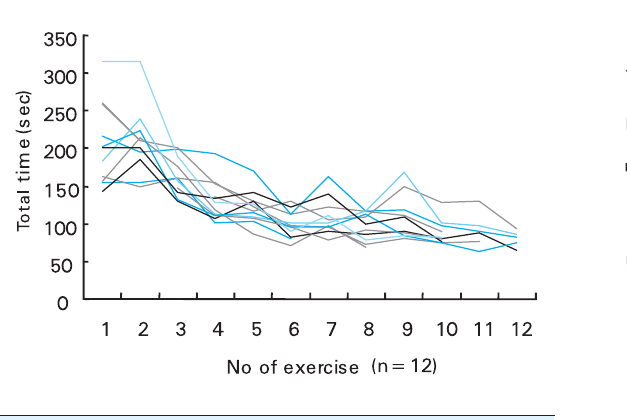
Figure 1. A graph showing time required to complete the tasks from exercise one to six.